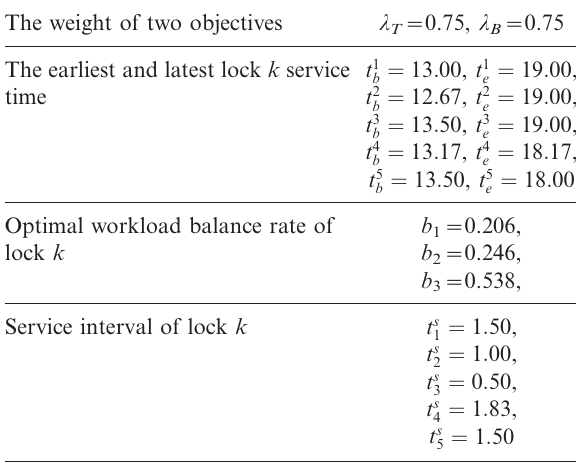
Table 3. Parameter values provided by the Navigation Department The weight of two objectives